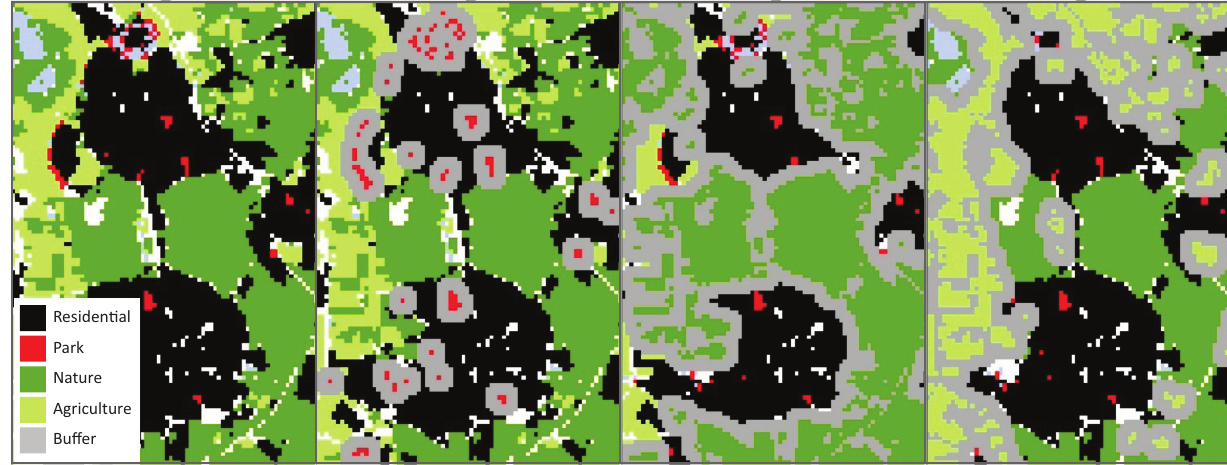
Figure 3. An example of a residential area surrounded by agricultural and natural open spaces and parks. Notes: On the left, are the main categories of land use; the three figures to the right show the 300‐m buffers around parks, nature, and agriculture,